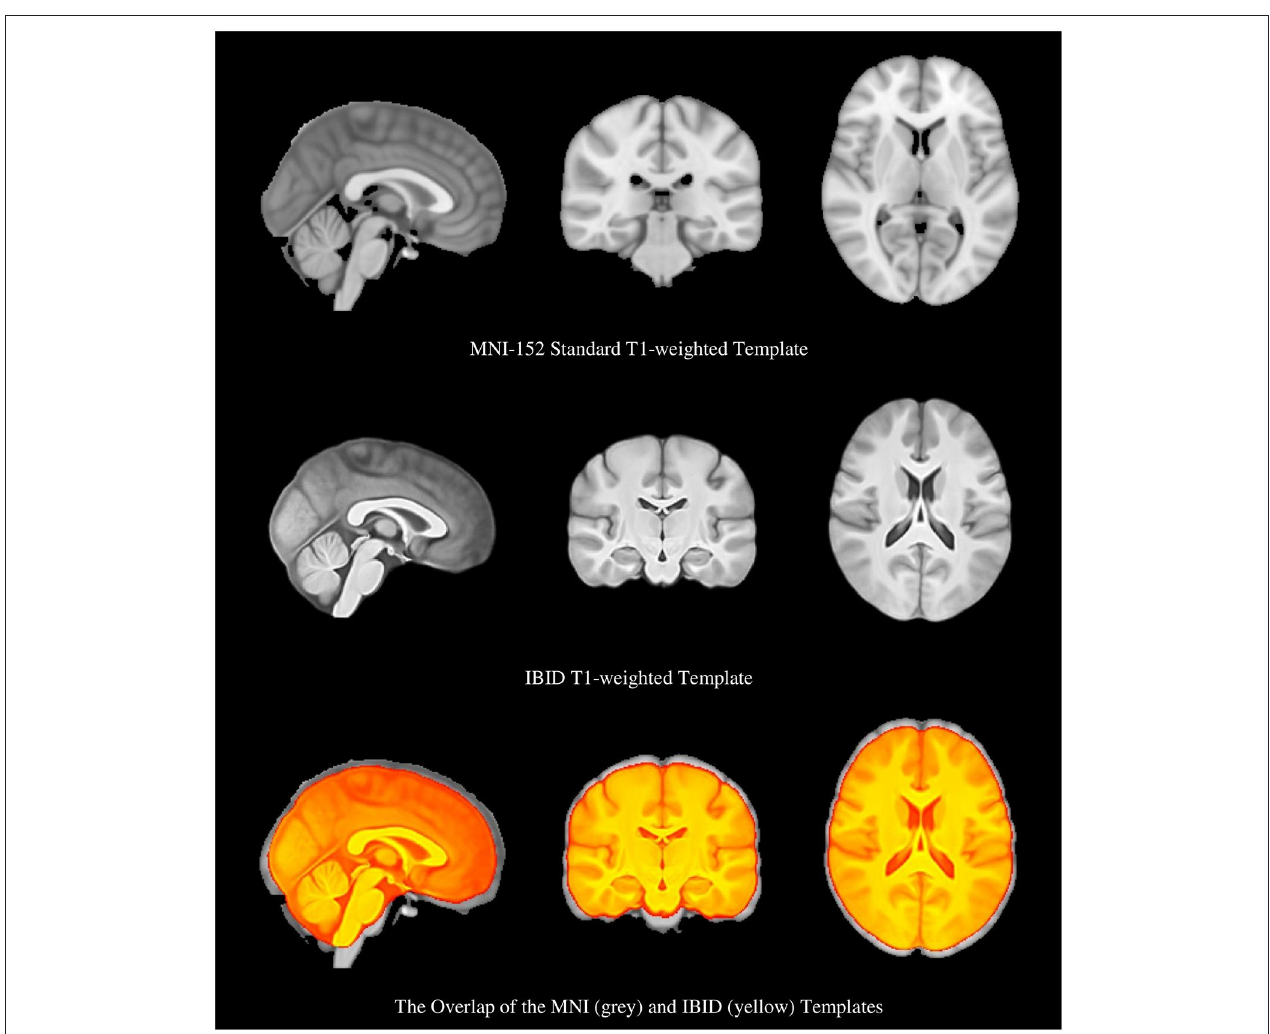
FIGURE 3 | The Montreal Neurologic Institute (MNI) brain template, the local brain template, and the overlap of the two templates, which show their different